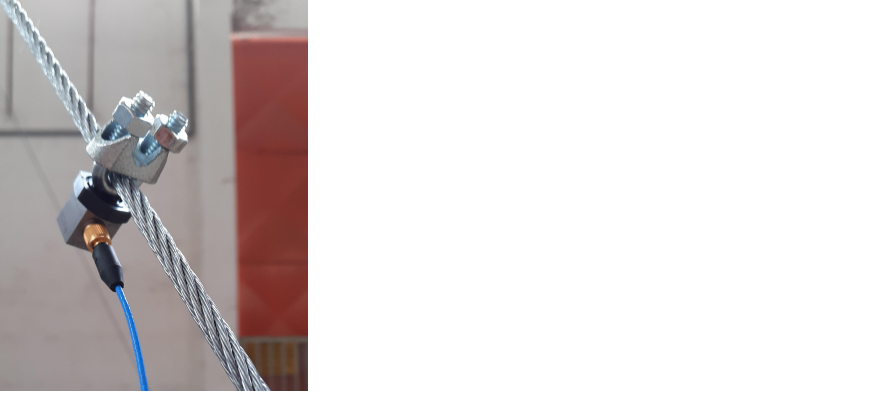
Figure 16. Detail of the fixation of the accelerometers at approximately 65% of the cable